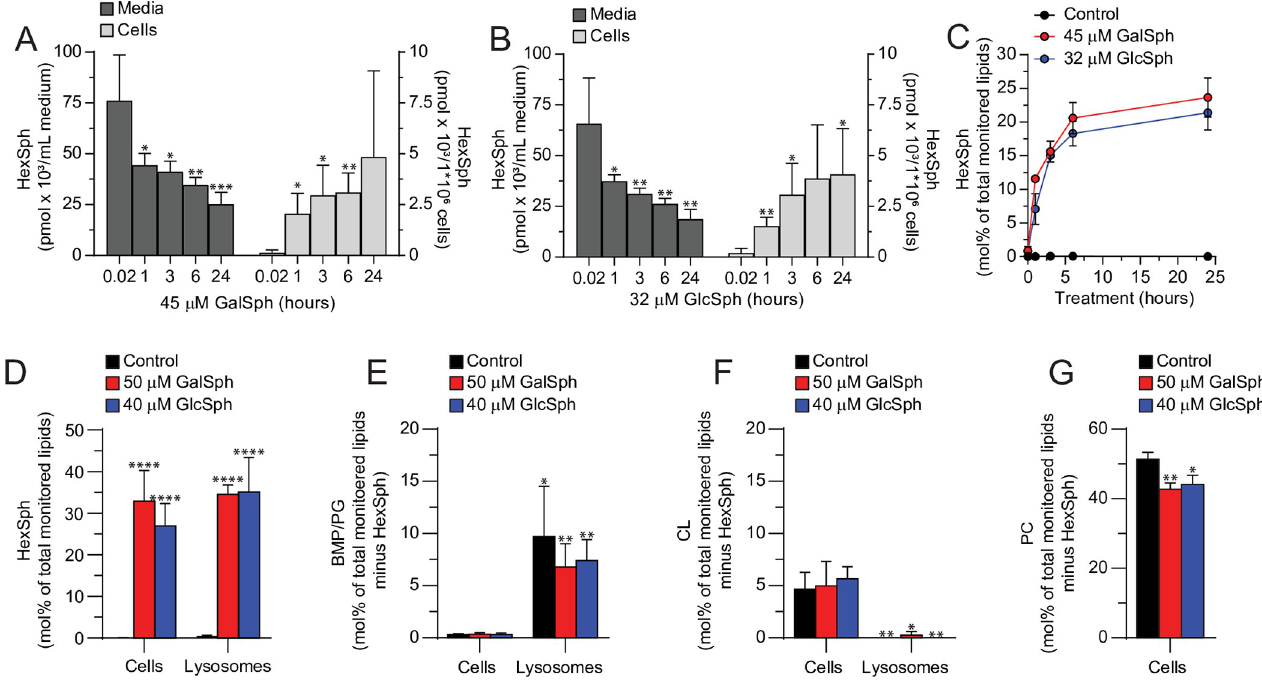
Fig 4. Extracellular GalSph and GlcSph enter the lysosomes of MCF7 cells. (A, B) Quantitites of HexSph (GalSph and GlcSph) in cell lysates (cells) and cell culture medium (media) of MCF7 cells treated with 45 μ M GalSph (A) or 32 μ M GlcSph (B) for indicated times were analyzed by shotgun lipidomics. (C) The molar percentages (mol%) of HexSph in MCF7 cells treated with 45 μ M GalSph or 32 μ M GlcSph for indicated times were analyzed as in (A). (D-G) The molar percentages of HexSph (D), BMP/PG (E), CL (F), and PC (G) lipid classes in total cell lysates (cells) and in purified lysosomes of MCF7 cells treated as indicated for 3 hours were analyzed as in (A). Error bars, SD of three independent experiments. � , P < 0.05; �� , P < 0.01; ��� , P < 0.001, ���� ; P < 0.0001 comparing the treated values to the first measurement at 0.02 hours (A, B) or to the control appropriate sample (D-G) and analyzed by unpaired t-test (A, B, E-G) or two-way ANOVA followed by Sidak’s multiple comparisons test (D). BMP, bis(monoacylglycero)phosphate; PG, phosphatidylglycerol; CL, cardiolipin; PC,